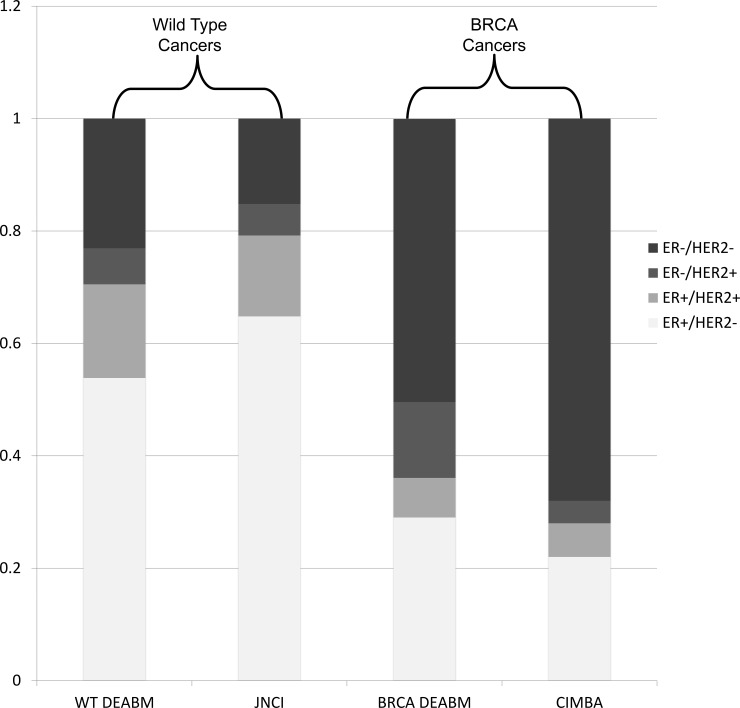
The proportion of tumors expressing ER and HER-2 in wild-type (WT) and BRCA1-mutated tumors generated by the Duct Epithelium Agent-based Model (DEABM).Individual tumors were grouped into one of four categories by combined estrogen receptor (ER) and HER-2 expression status. WT data from the DEABM is compared against data on ER and HER-2 status of breast tumors from the SEER database[45]. BRCA1-mutated data from the DEABM is compared against CIMBA data on ER and HER-2 status of tumors in a population of BRCA mutation carriers.[51]